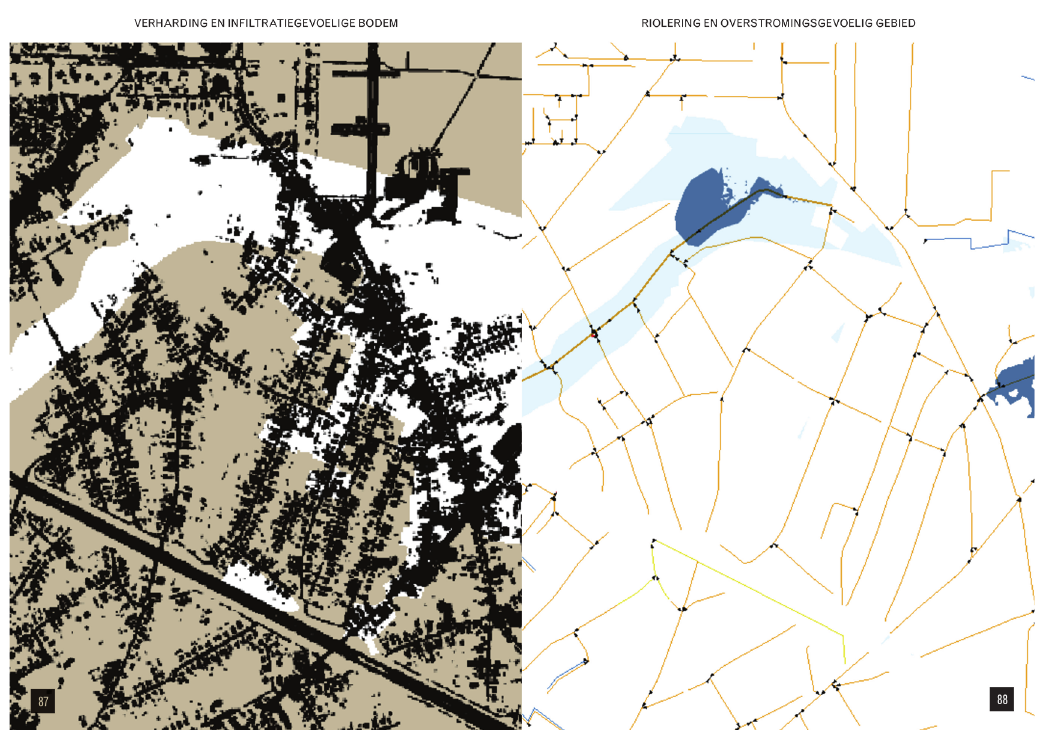
Figure 4. Double page from the second section ‘perspectives’ of the atlas showing the neighbourhood’s sewerage system (orange) and flood zones (blue) on the right against the neighbourhood’s mineralized surface (black) and soil suitable for infiltration (brown) on the left. Source: Anse Arits (based on the watertoets [water check] 2017 and sewerage database of Flanders 2018 [right map] and BAK 2015 [soil cover map of Flanders; left